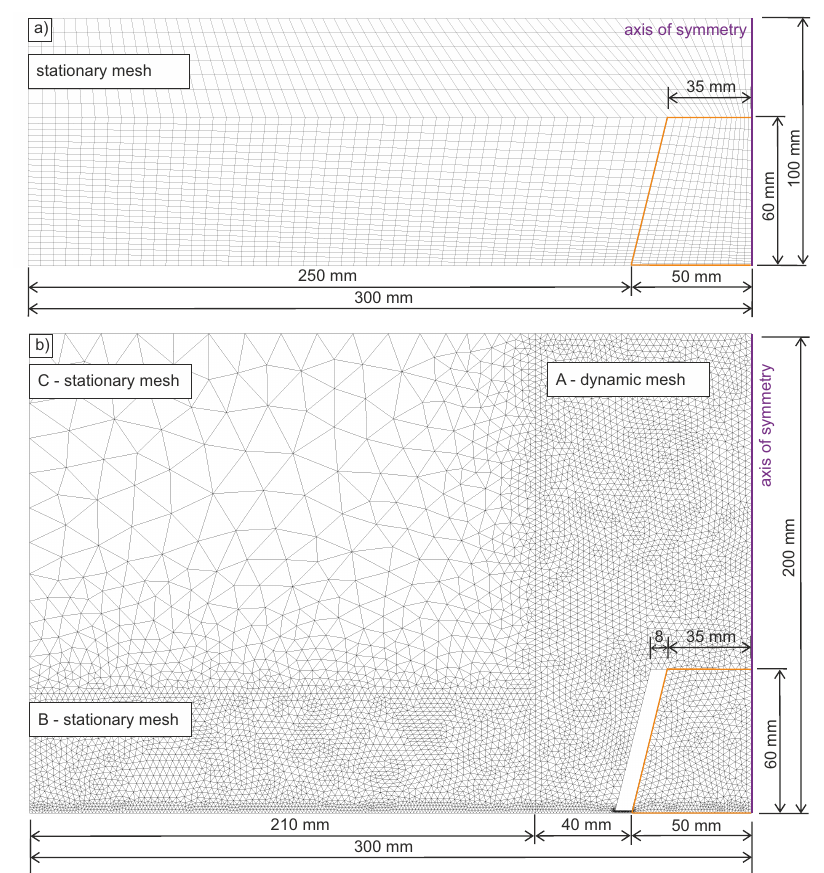
Figure 2. Mesh used for the slump test modeling a) without mold b) with